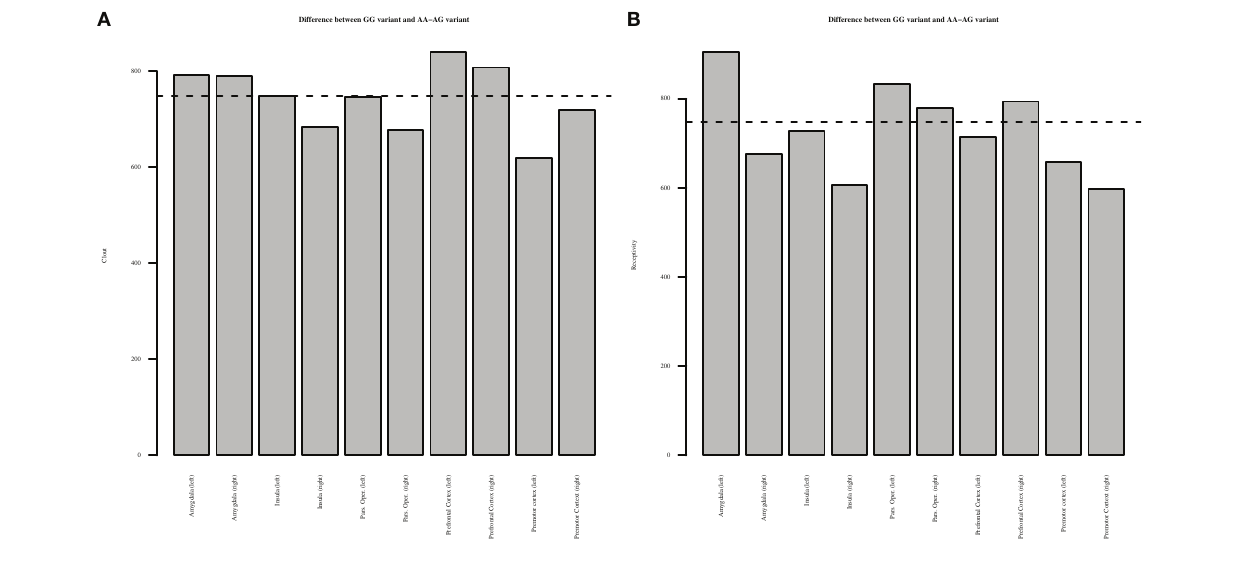
brain region in the AG and AA allele groups is equal to zero. Bars exceeding the dotted line show significantly higher clout (A) or receptivity (B) for the GG allele group than for the AG and AA allele groups at a 1% probability level.